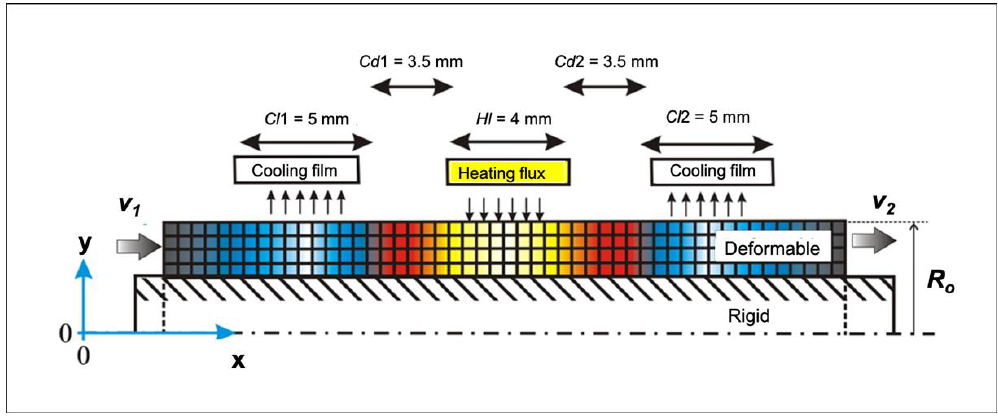
Schematic of the finite element model for the asymmetrical semi-dieless bellows forming process.